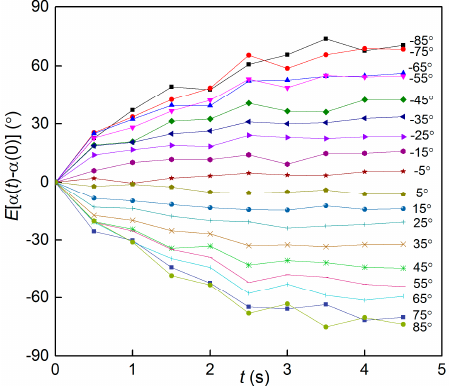
Figure 13. Variation of average turning amplitude with time at different angles α (0).